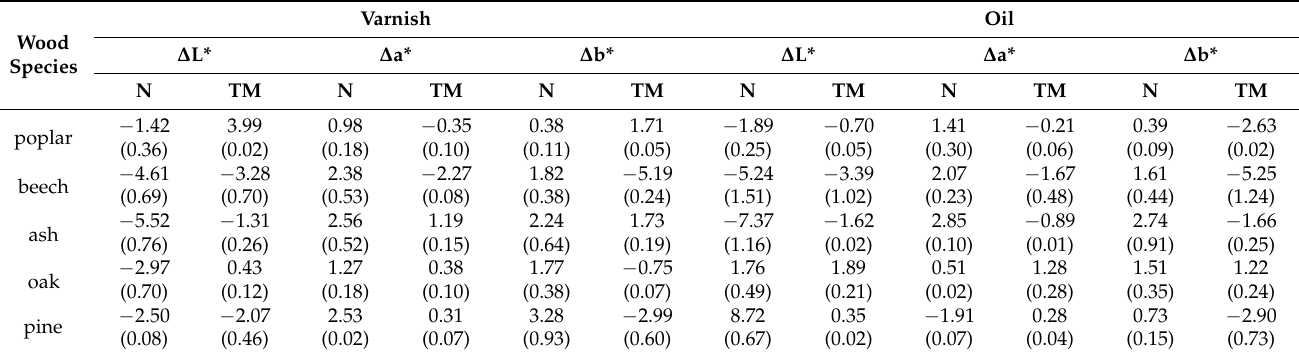
Table 6. Changes of the wood colour parameters (standard deviation in parentheses) after the surface photoaging.